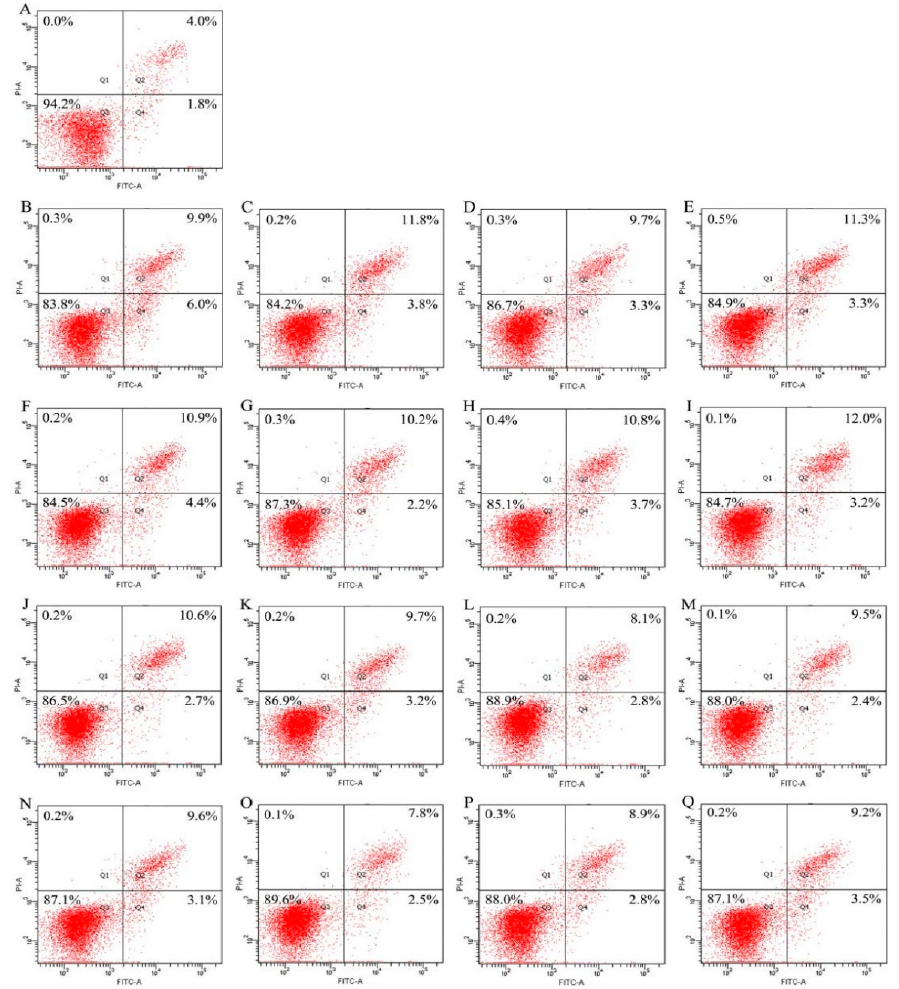
Figure 3. The apoptotic proportions in the osteoblasts detected using flow cytometry after apoptotic prevention by apoptotic rescue of genistein (Gen), three hydrolysates, and three Gen-hydrolysate combinations. ( A ) control cells; ( B ) EP-treated cells; ( C – I ) the cells firstly treated by EP at 10 mg/L, and then treated by Gen, GH2, SH2, CH2, Gen-GH2, Gen-SH2, and Gen-CH2, respectively; ( J ) NaF-treated cells; ( K – Q ) the cells first treated by NaF at 40 mg/L, and then treated by Gen, GH2, SH2, CH2, Gen-GH2, Gen-SH2, and Gen-CH2, respectively. GH2, SH2, and CH2 were the hydrolysates generated from gelatin, de-isoflavoned soy protein, and casein with DH values of 13.7%, 13.5%, and 13.3%, respectively. The hydrolysates and Gen were used at 0.05 g/L and 2.5 μ g/L, respectively. EP represents etoposide while the labeled Q1–Q4 represent necrotic, later apoptotic, viable, and early apoptotic cells, respectively.